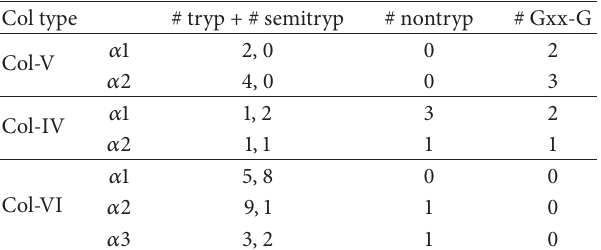
Table 2: Collagen peptide identification from tissue digestion sam-